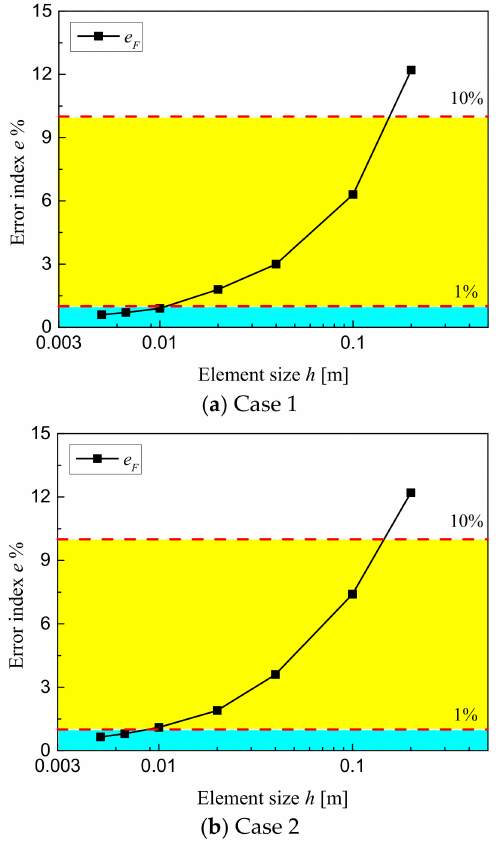
Figure 5. Relationship of error and mesh size for intersecting fracture